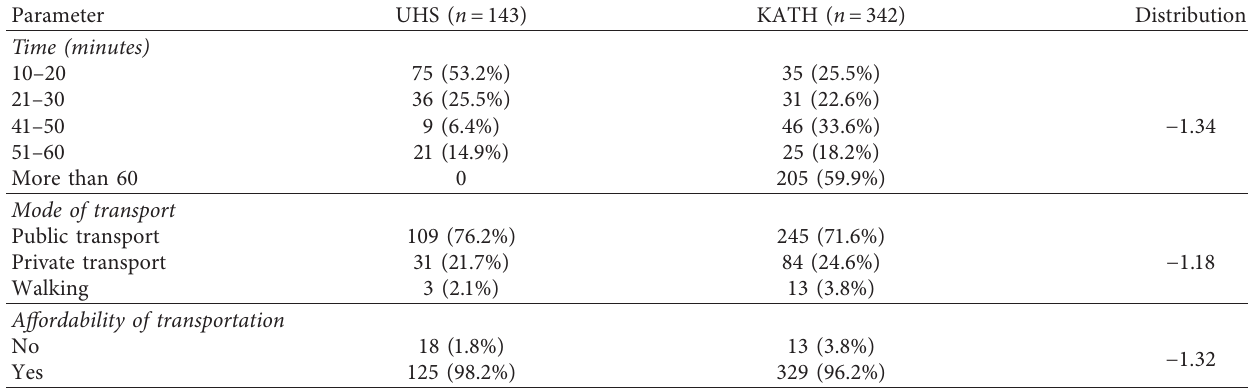
Table 2: Accessibility to healthcare facilities.